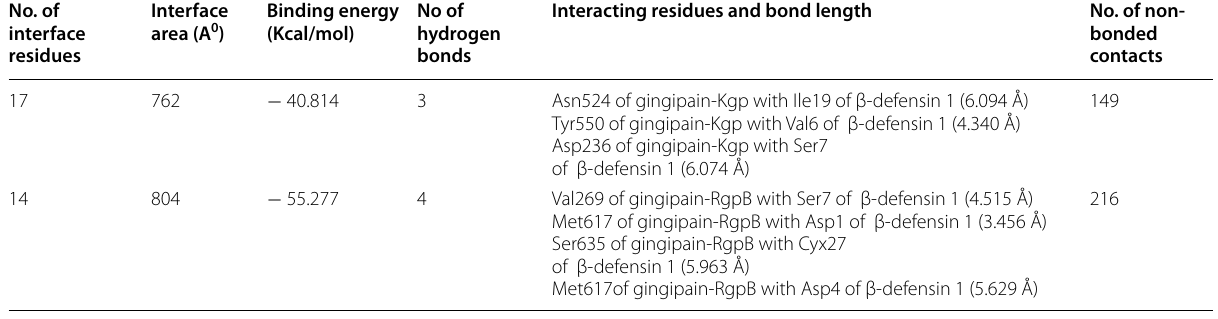
Table 7 Interaction results of β-defensin 1 against gingipains Kgp and RgpB of P. gingivalis No. of interface